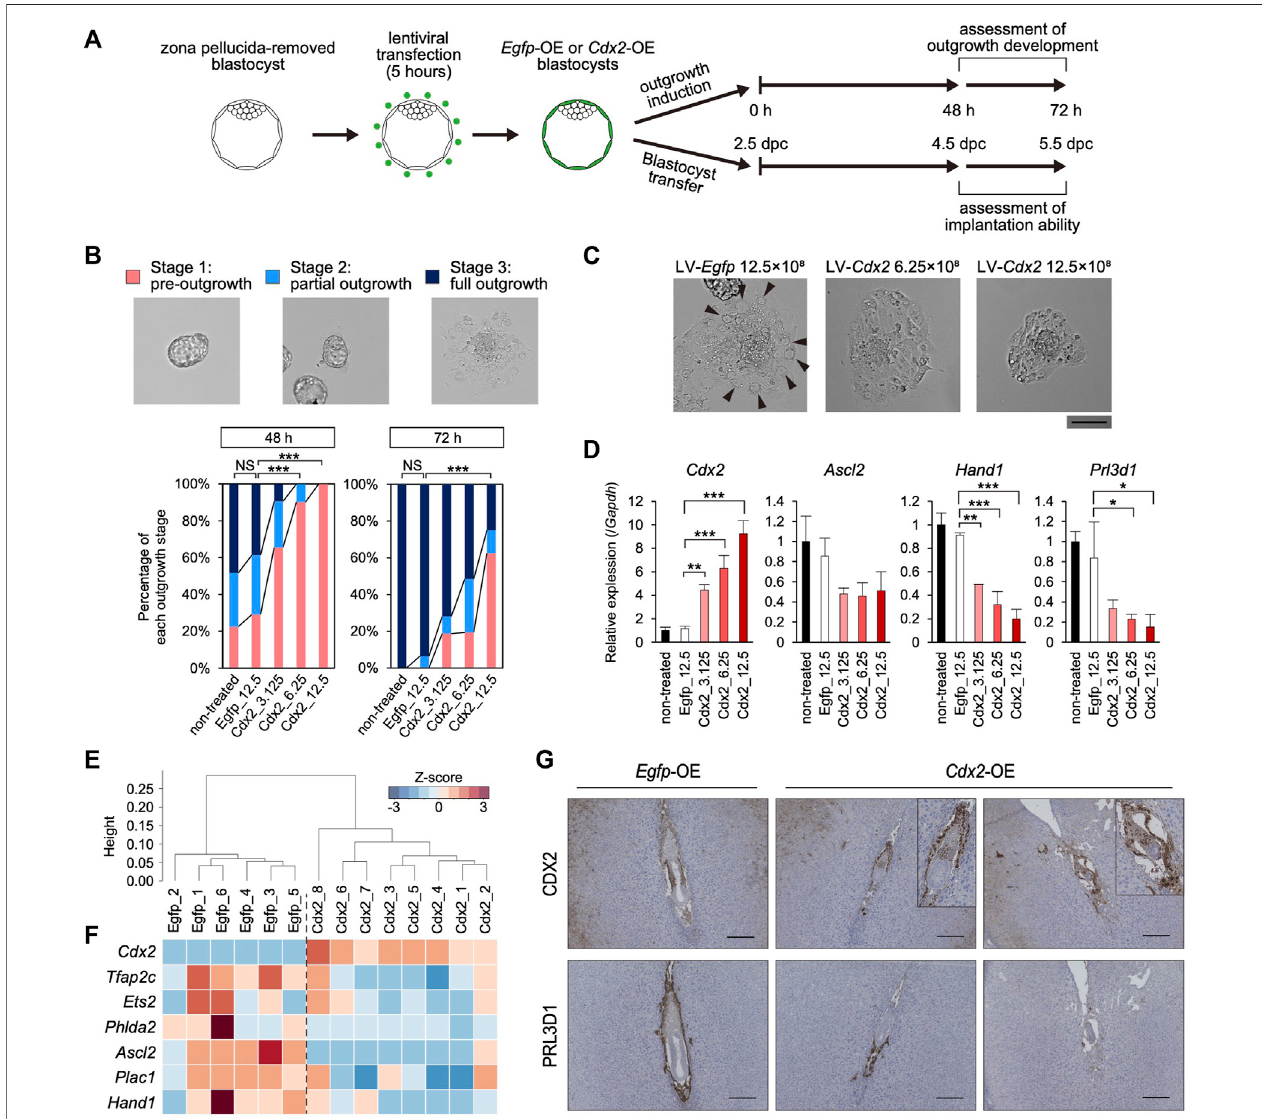
FIGURE3| TheeffectofTE-speci fi c Cdx2 overexpressionondifferentiationofthemTE (A) Aschemefortheproductionof Egfp -OEand Cdx2 -OEblastocysts,and the subsequent experiments: outgrowth induction and in vivo development after transfer into uteri (B) Representative images and percentage of embryos in each outgrowth stage. Fisher ’ s exact test; *** p < 0.001. NS: not signi fi cant (C) Higher magni fi cation images of blastocyst outgrowth. Arrowheads indicate the cells showing TGC-like morphology. Scale bar: 100 µm (D) RT-qPCR analysis of Cdx2 and differentiation marker genes ( Ascl2 , Hand1 and Prl3d1 ) in blastocyst outgrowth. The values are normalized to Gapdh and indicated as the mean ± S.D. (n = 3). Dunnett test; * p < 0.05, ** p < 0.01, *** p < 0.001 (E) Hierarchical clustering analysis based on global gene expression (F) Heatmap showing the expression levels of Cdx2 and differentiation marker genes. In particular, Cdx2 , Ascl2 and Phlda2 were identi fi ed as DEGs (fold-change ≥ 2, FDR p -value ≤ 0.01) (G) Egfp -OE and Cdx2 -OE E5.5 conceptuses labelled for CDX2 or PRL3D1. Boxed regions are shown at higher magni fi cation of conceptuses.